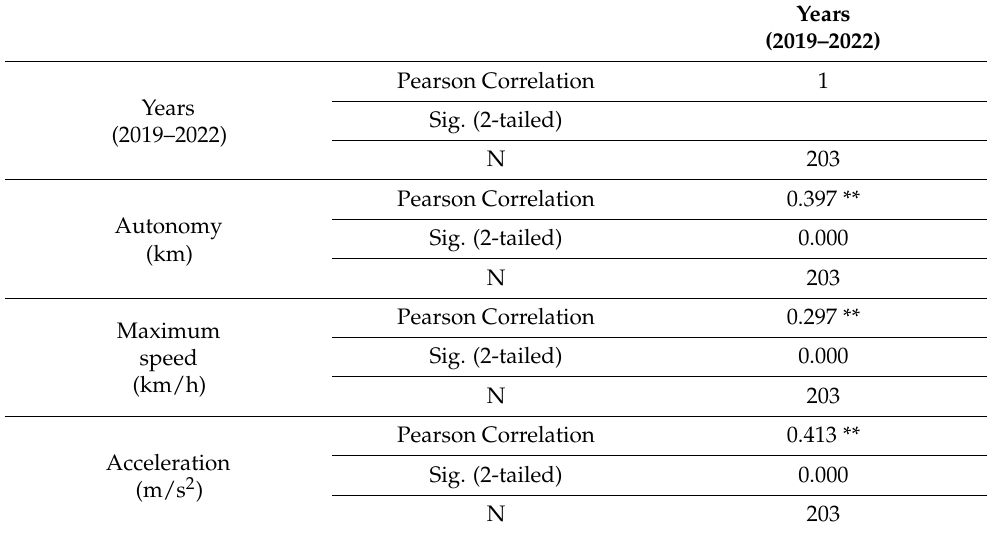
Table 6. Correlation coefficients between the performance parameters and the year of